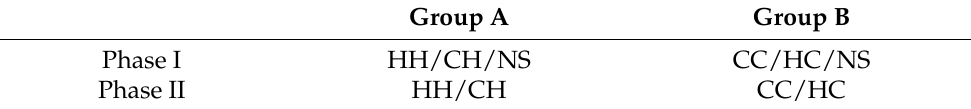
Table 2. Distribution of musical pieces into groups according to the